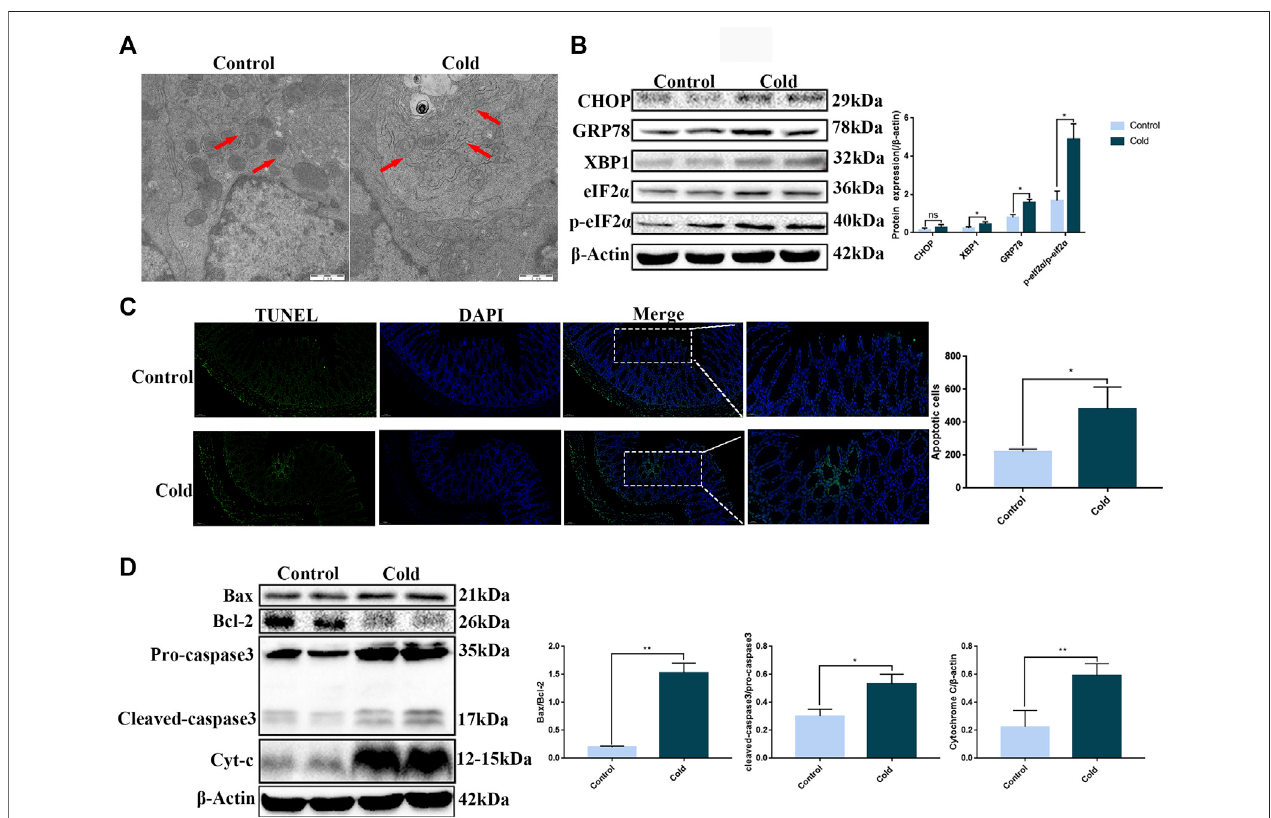
FIGURE 2 | Cold exposure induces ER stress and apoptosis in mouse colon tissue. (A) Representative TEM images of mice colon, the red arrows indicate ER, scale bar: 1 µm. (B) CHOP, GRP78, XBP1, eIF2 α , and p-eIF2 α protein expression levels were measured by western blot analysis in mouse colon tissue. (C) Apoptosis was measured in mouse colon tissue using TUNEL staining. (D) Bax, Bcl-2, caspase-3, and Cytochrome C protein expression levels were measured by western blot analysis in mouse colon tissue. Data are presented as the mean ± SEM ( n = 3). Statistically signi fi cant differences are indicated; * p < 0.05, ** p < 0.01, *** p < 0.001, signi fi cantly different from control